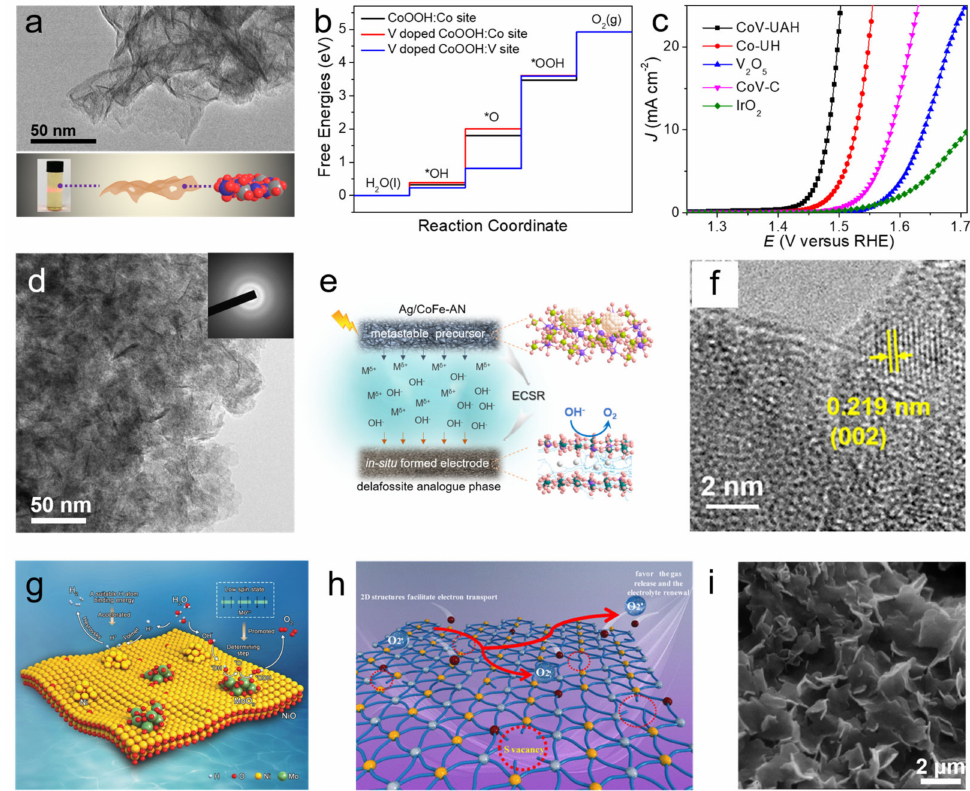
Figure 6. ( a ) The TEM image of CoV-UAH; ( b ) The free-energy landscape for V doped cobalt oxyhydroxide; ( c ) Linear sweep voltammetry curves for CoV-UAH and counterparts. Reprinted with permission from Ref. [17]. Copyright Royal Society of Chemistry, 2018. ( d ) The TEM image of amorphous delafossite analogue nanosheets, and inset is selected area electron diffraction (SAED); ( e ) Self-reconstruction process. Reprinted with permission from Ref. [62]. ( f ) HRTEM image of EBP/CoFeB sample. Reprinted with permission from Ref. [41]. Copyright American Chemical Society, 2021. ( g ) The enhanced mechanism of hybrid nanocatalysts for overall water splitting. Reprinted with permission from Ref. [72]. Copyright Wiley-VCH, 2020. ( h ) Activity mechanism for Mo–FeS nanosheets with sulfur defects. Reprinted with permission from Ref. [84]. Copyright on Ni foam. Reprinted with permission from Ref. [88]. Copyright Wiley-VCH,